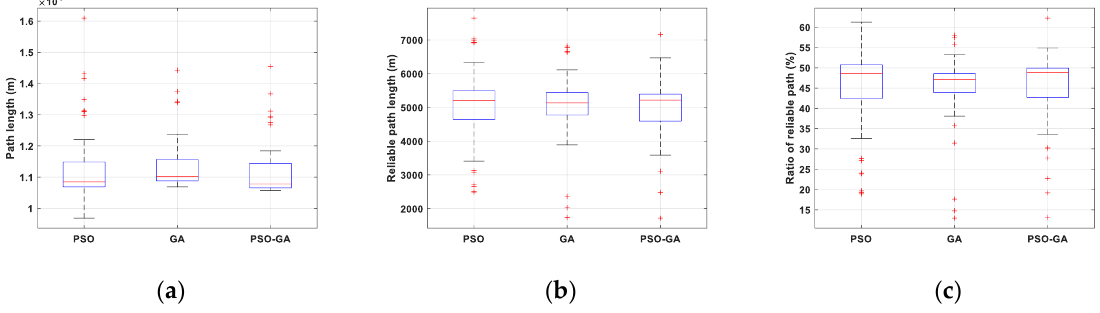
Figure 15. Statistical results of Scenario III: ( a ) optimal path, ( b ) reliable path, and ( c ) ratio of the reliable path.